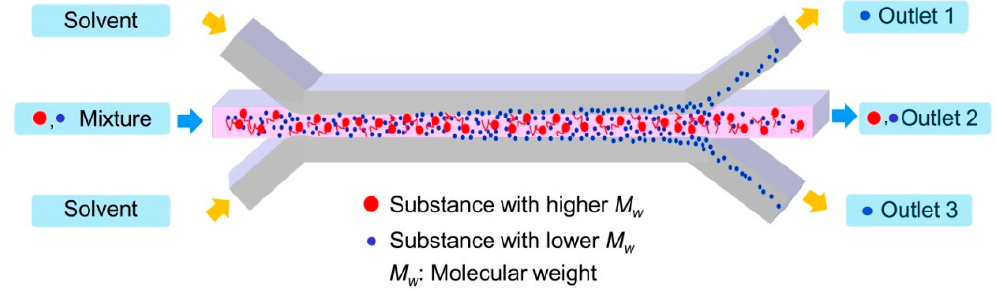
Figure 1. Separation of only small molecules from the mixture of two different molecules using the different transverse diffusion in a lamination flow.